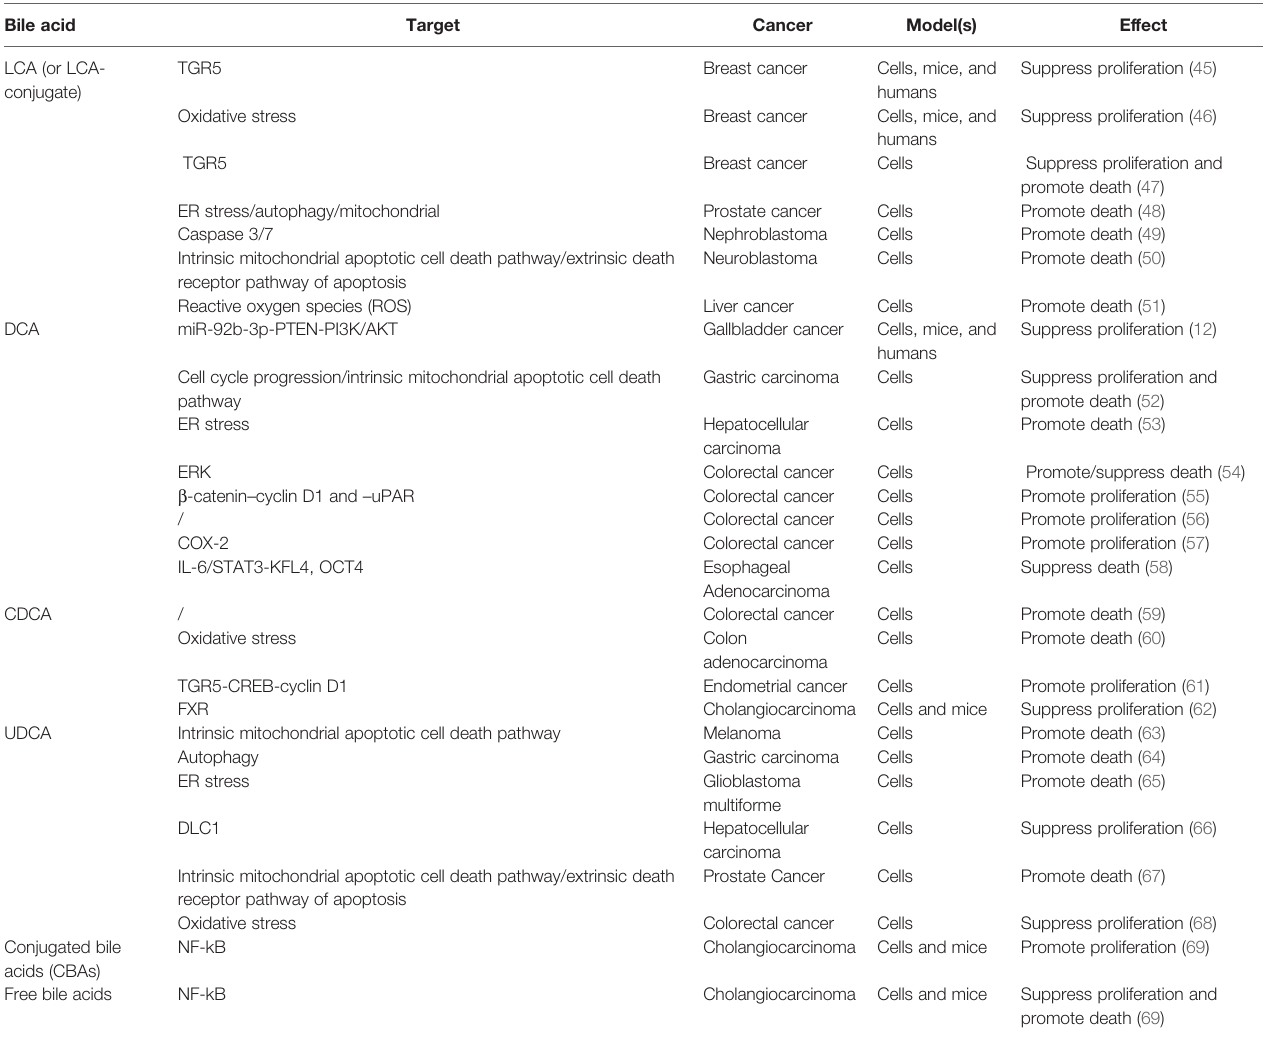
TABLE 2 | The impact of bile acid on cancer cell proliferation and death. Bile